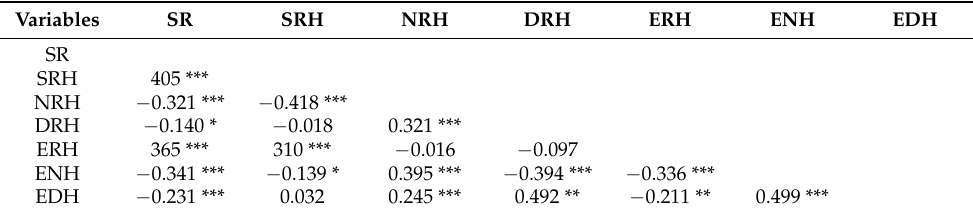
Table 5. Bivariate correlations between self-regulation and types of health regulation (internal and external) ( n = 269).